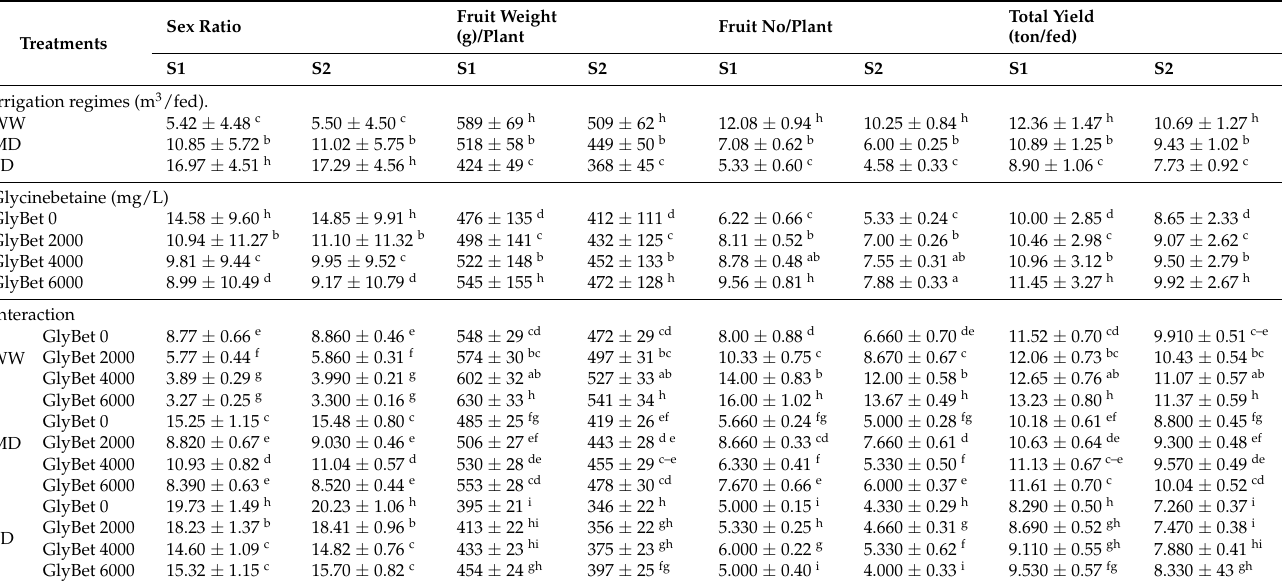
Table 5. Sex expression and yield components of cucumber plant as affected by GlyBet concentration, irrigation regimes, and their interactions in both seasons 2020 and 2021.